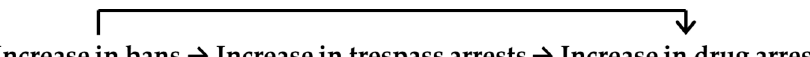
Figure 1. Theoretical path model between bans and drug arrests.